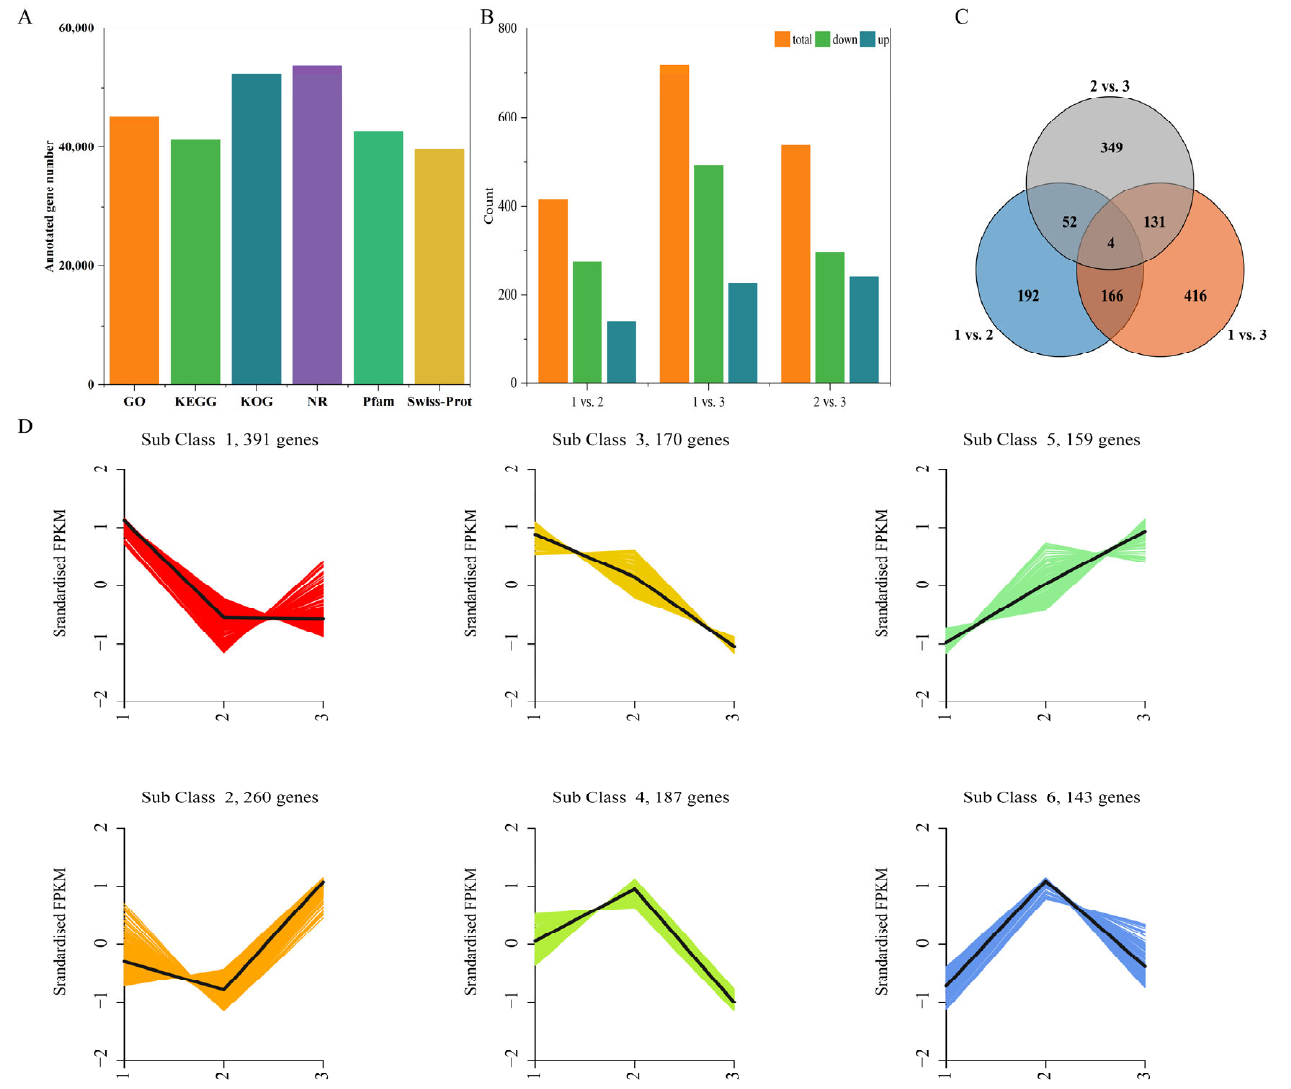
Figure 4. Analysis of the transcriptome data. ( A ) The numbers of annotated genes by GO, KEGG, KOG, NR, Pfam, and Swiss-Prot databases; ( B ) The numbers of differentially expressed genes; ( C ) Venn diagram of the differentially expressed genes among three comparison groups; ( D ) K-means cluster analysis of the differentially expressed genes. Numeral 1 represents the 5 °C DIF treatment; numeral 2 represents the 10 °C DIF treatment; and numeral 3 represents the 15 °C DIF treatment.